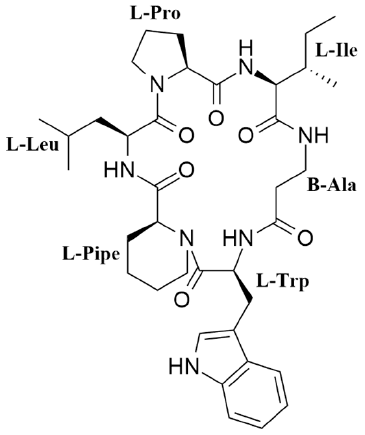
Figure 1. Structure of pipecolisporin ( 1 ).